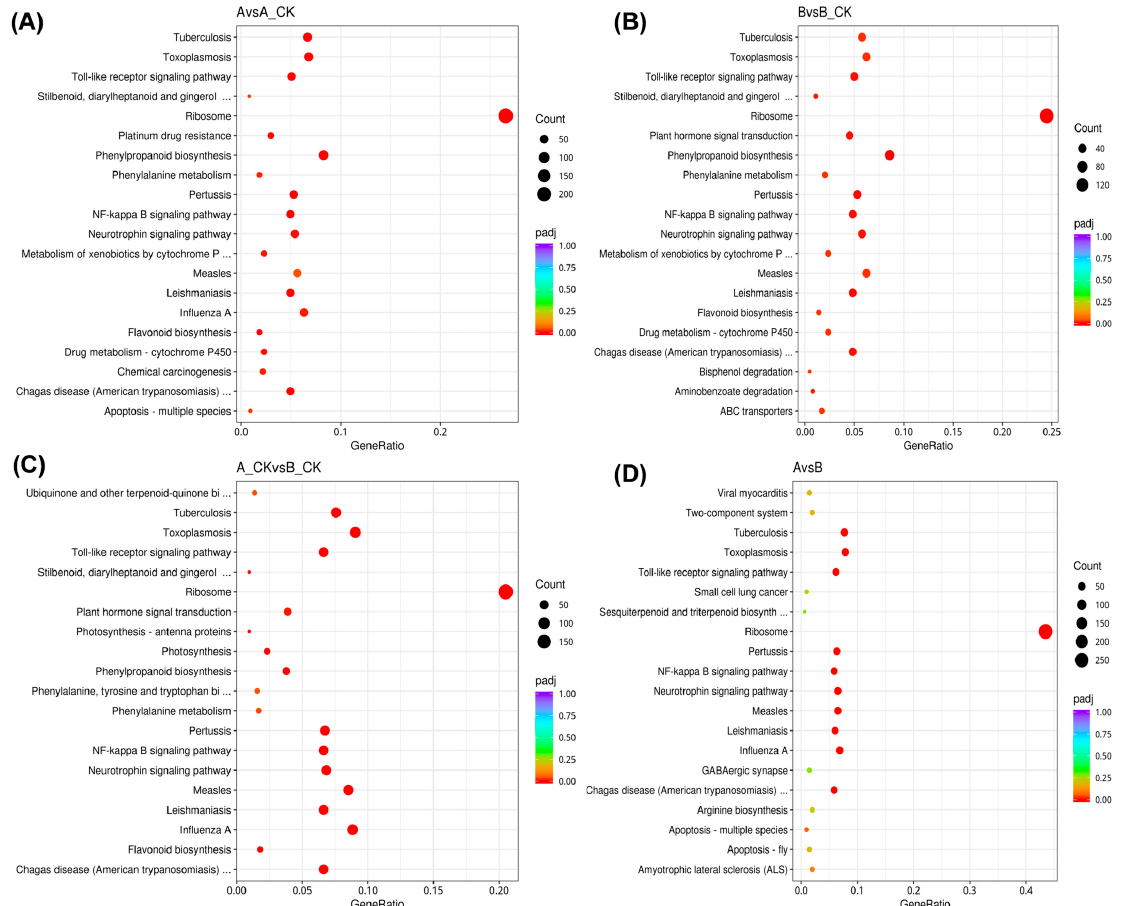
Figure 4. Kyoto Encyclopedia of Genes and Genomes (KEGG) pathway enrichment scatter plot. ( A ) Comparison between A and A-CK, ( B ) Comparison between B and B-CK, ( C ) Comparison between A-CK and B-CK, ( D ) Comparison between A and B. The vertical axis represents the path name, and the horizontal axis represents the path factor corresponding to the Rich factor. The size of the q-value is represented by the color of the point. The smaller the q-value, the closer the color is to the red color. The number of differential genes included in each pathway are expressed by the size of the point. Treatments: A-CK (Dawei-un-inoculated control), A (Dawei- inoculated with B. cinerea ), B-CK (Qiuxiang-un-inoculated control), B (Qiuxiang- inoculated with B. cinerea ).